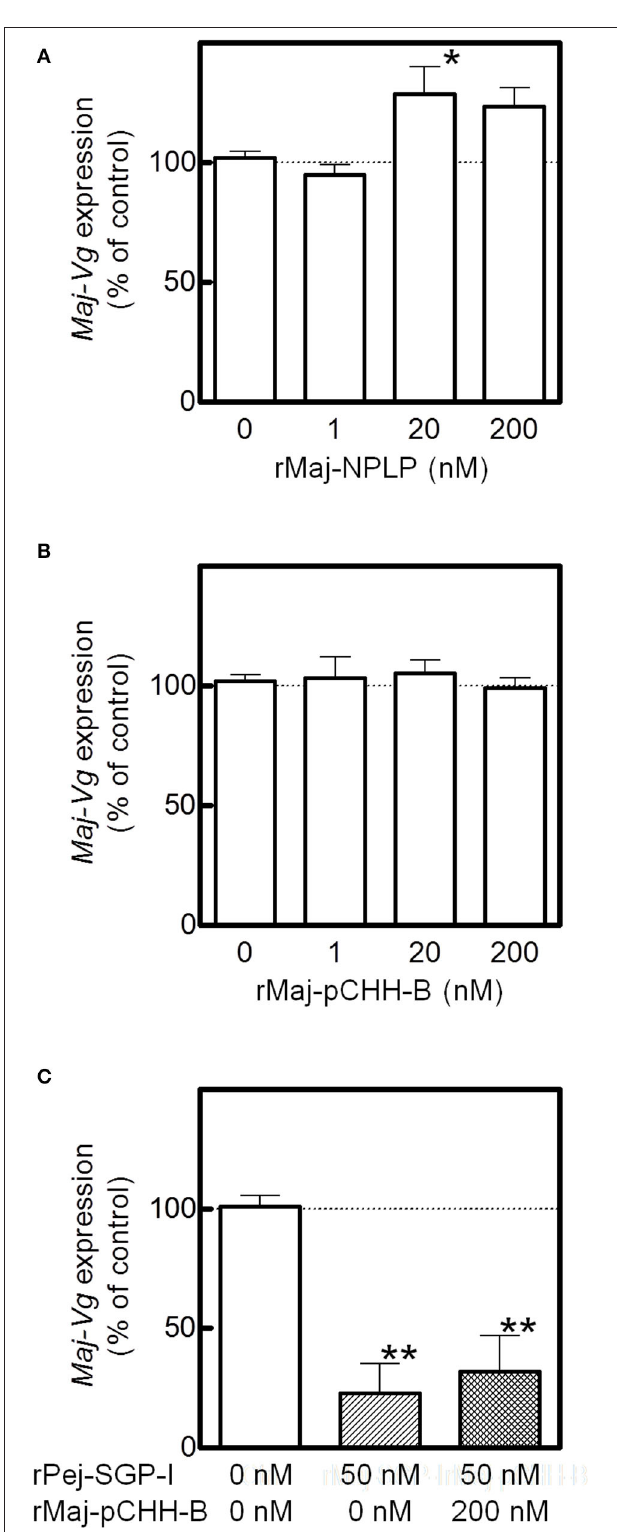
FIGURE 6 | Analyses of rMaj-NPLP and rMaj-pCHH-B functions. Maj-VG expressions in ex-vivo ovarian fragments incubated with (A) rMaj-NPLP